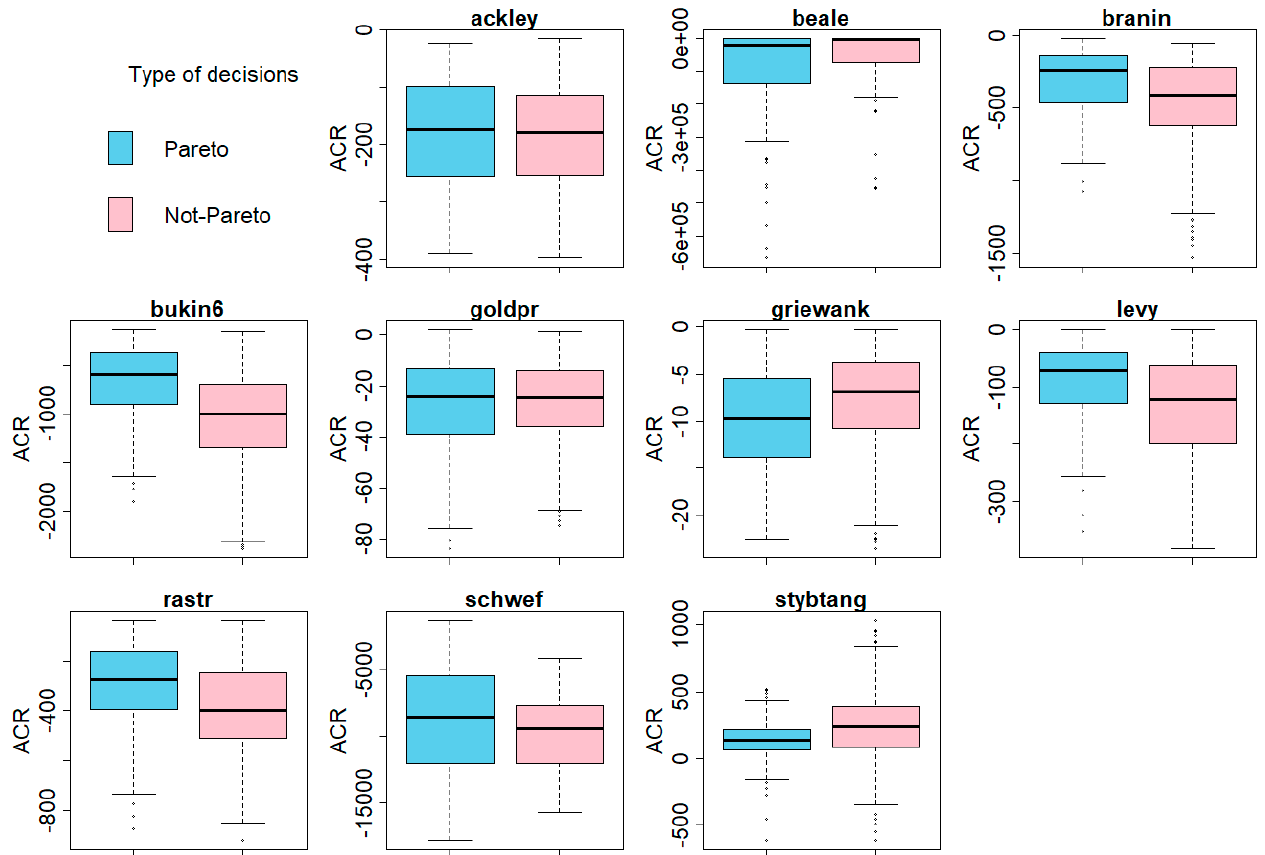
Figure 3. ACR with respect to Pareto and Not-Pareto decisions, separately for each test function.